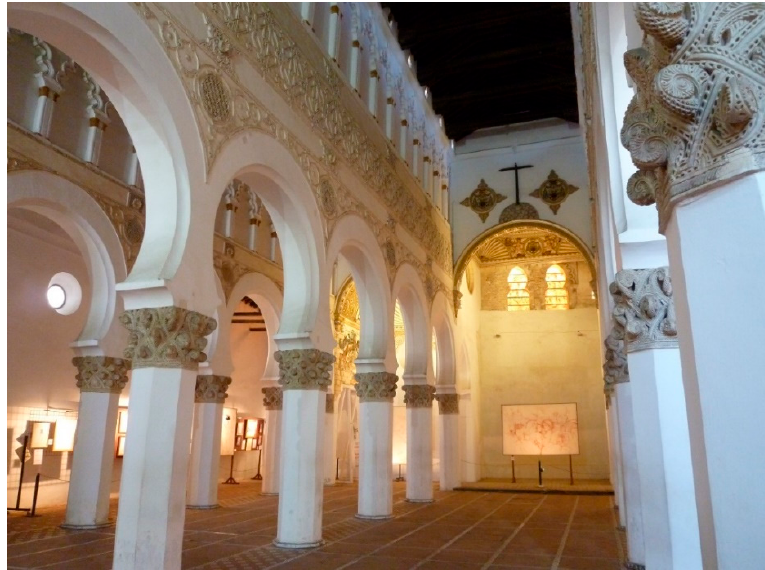
Figure 3. Central nave of the Synagogue of Santa María la Blanca of Toledo. Author’s photo.